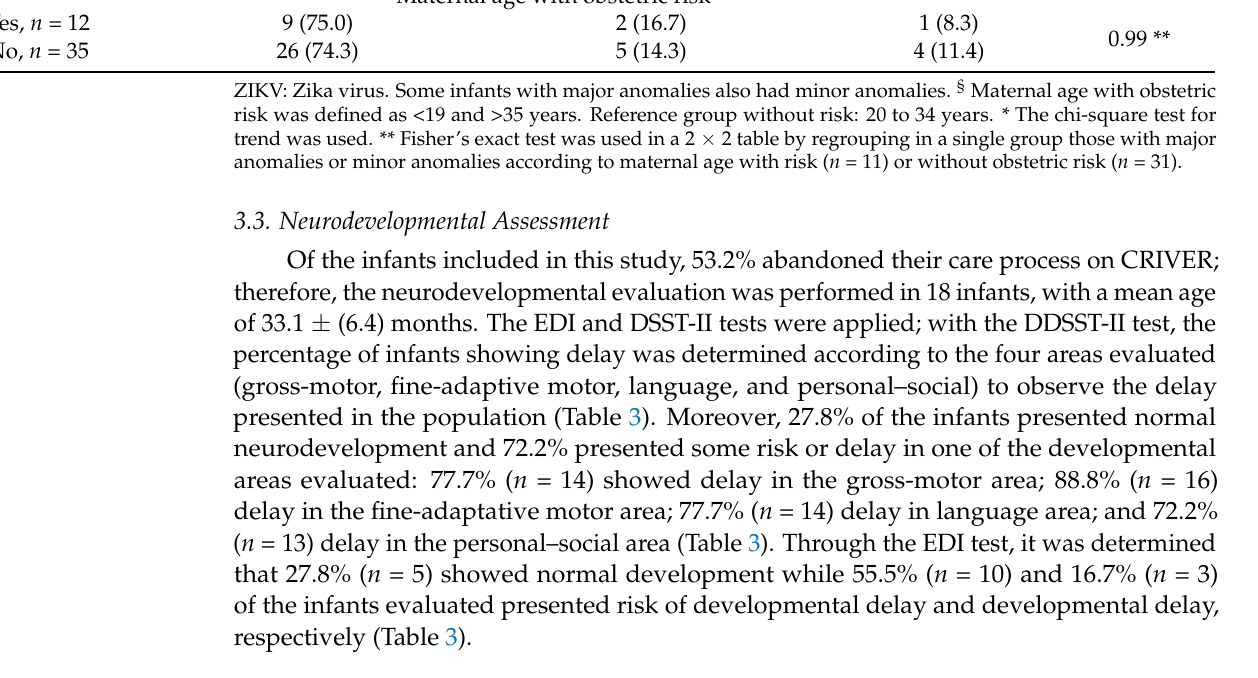
Table 3. Neurodevelopmental assessment in children exposed to ZIKV infection during